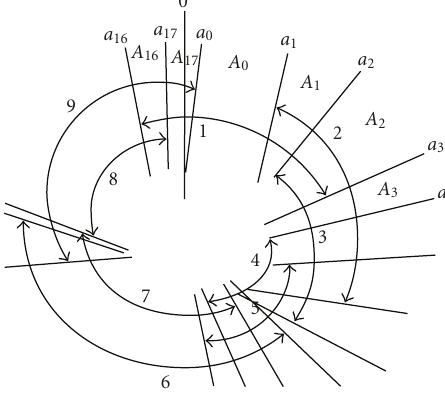
Figure 3: Example of perimeter